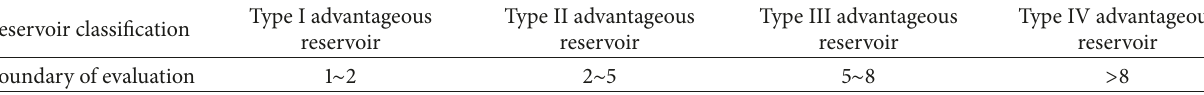
Table 1: Boundaries of advantageous reservoir classification